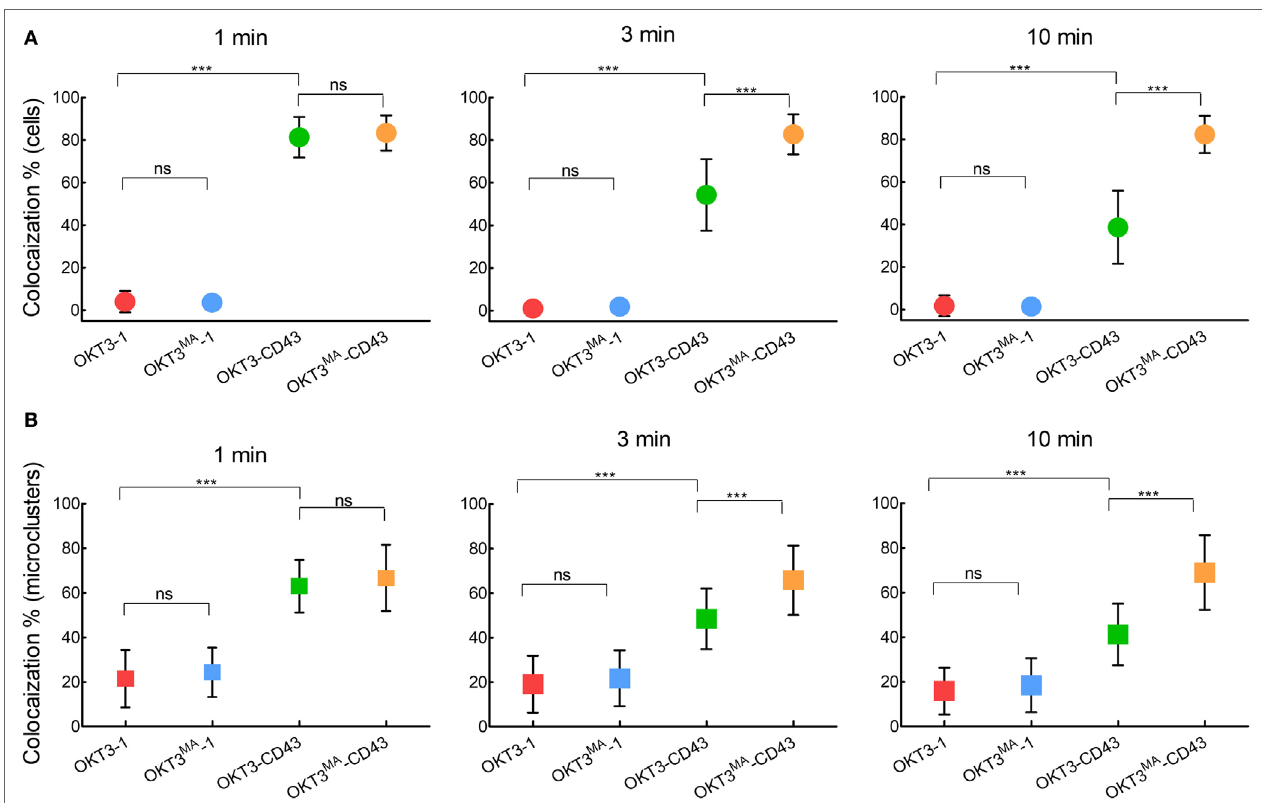
FigUre 6 | CD45 segregation from CD3 occurs after T cell activation by elongated ligands and increases with time. We compared segregation of CD3 and CD45 induced by ligands with the same length and different affinities at 1, 3, and 10 min as measured by (a) Co-localization percentage between CD3 and CD45 measured by intensity of overlapped pixels for individual Jurkat T cells. (B) Co-localization percentage between CD3 and CD45 measured by intensity of the overlapped pixels for individual microclusters obtained from Jurkat cells ( n = 26, 22, 27 and 20 cells for OKT3-BGP, OKT3 MA -BGP, OKT3-CD43, and OKT3 MA -CD43, respectively). Bars,